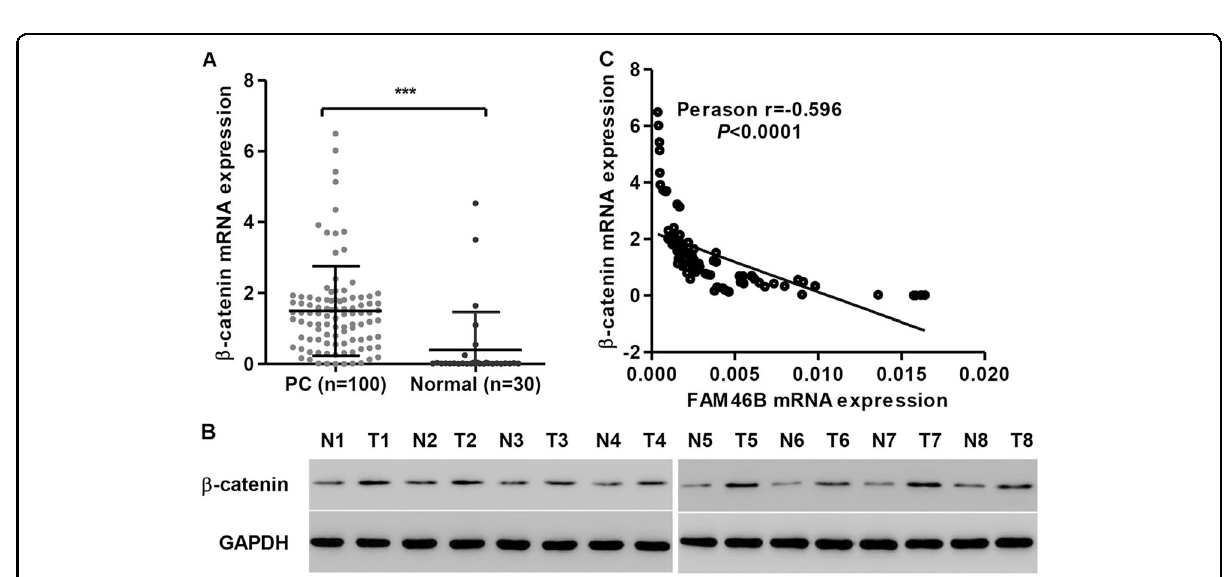
Fig. 7 FAM46B was negatively correlated with β -catenin in PC tissues The mRNA and protein expression of β -catenin in PC tissues and corresponding normal prostate tissues was measured by real-time PCR a and western blotting b . Linear regression showed that FAM46B mRNA expression was negatively correlated with the mRNA expression of β -catenin c . N1-8: normal prostate tissues; T1-8: PC